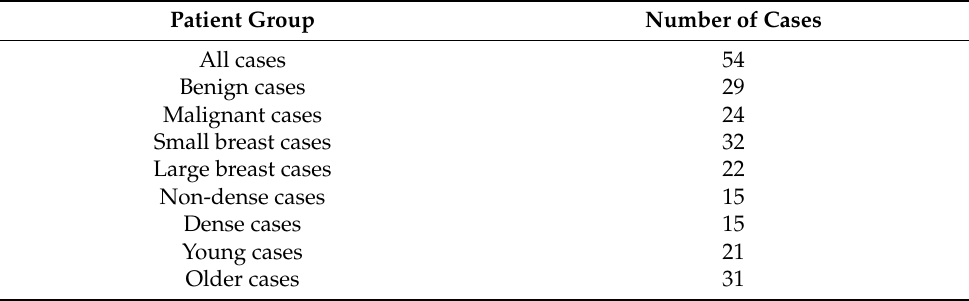
Table 1. Details of the dataset analyzed in the